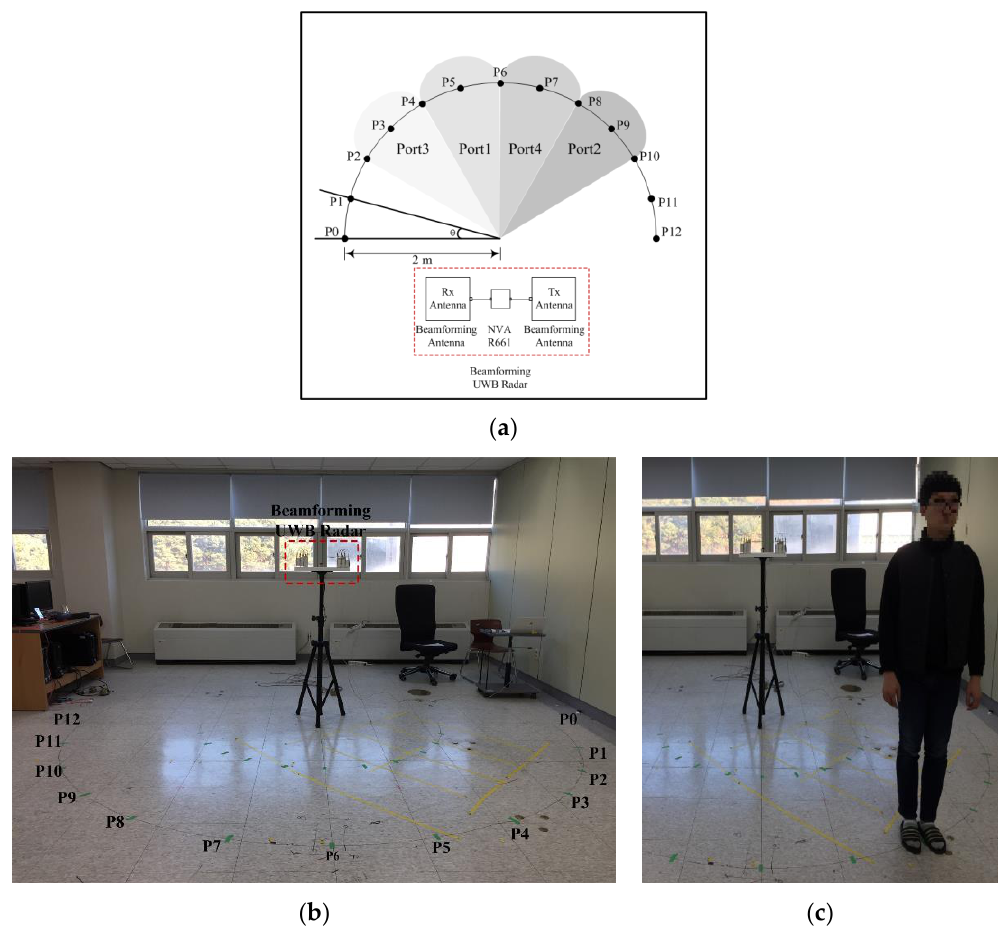
Figure 27. P roposed system: experiment environments (a) Configuration (b) #1 and (c) #2. Figure 27. Proposed system: experiment environments ( a ) Configuration ( b ) #1 and ( c )